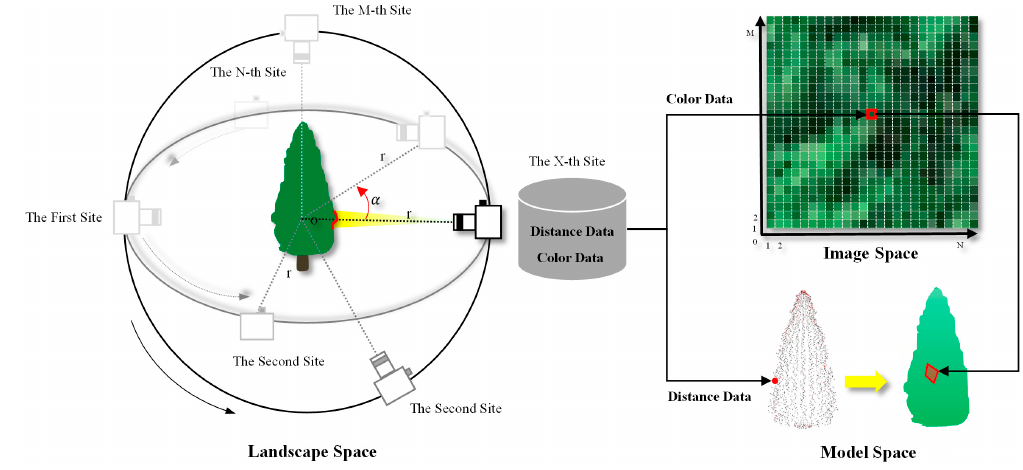
Figure 3. Schematic diagram of crown surface generation.